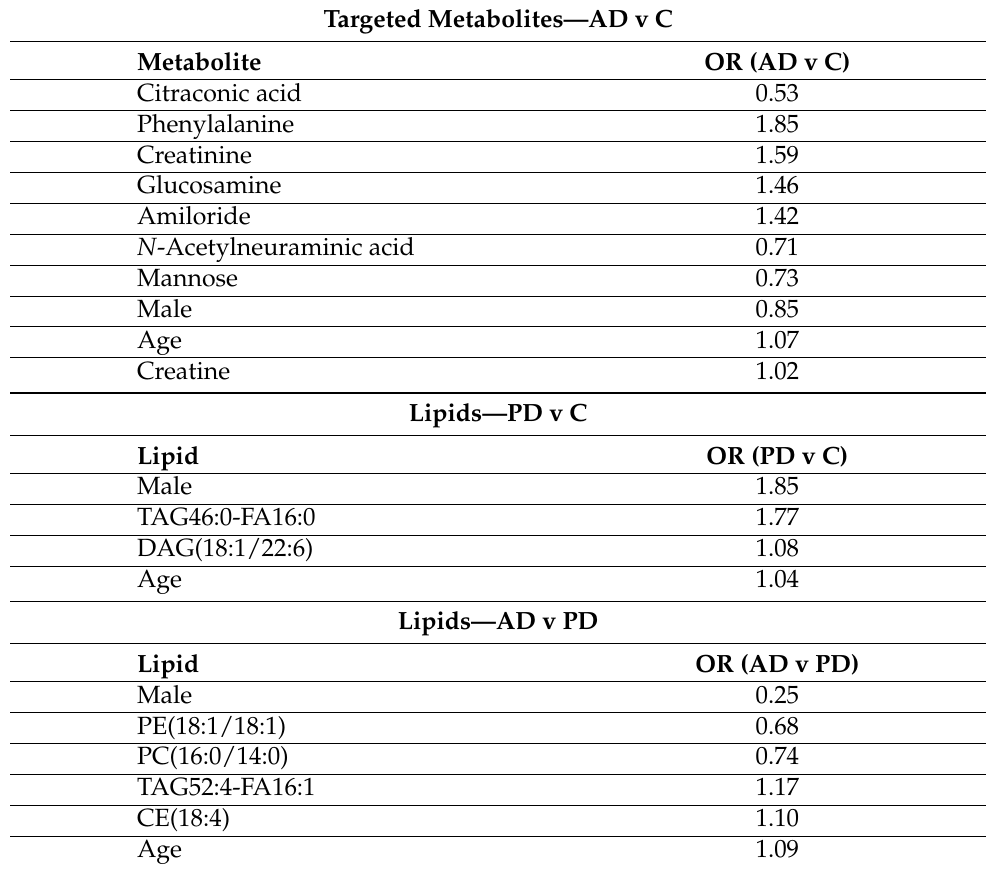
Table 5. Names and OR for targeted metabolite abundance missingness indicators in AD classification against controls, lipid abundance missingness indicators in PD classification against controls, and lipid abundance missingness indicators in AD classification against PD, retained in elastic net models fit on the full data. The OR corresponds to increased odds of classifying a patient as having AD/PD/AD associated with a standard deviation increase in metabolite concentration (for left, middle, and right, respectively). Age and sex are not penalized, and are therefore guaranteed to be included in these models. Other combinations of phenotype and profile (i.e., targeted-PD or lipids-AD tables) are not shown because the only retained covariates were age and